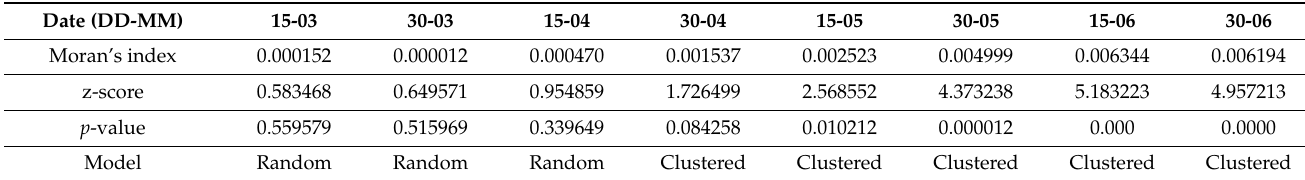
Table 5. Spatial autocorrelation observed for several